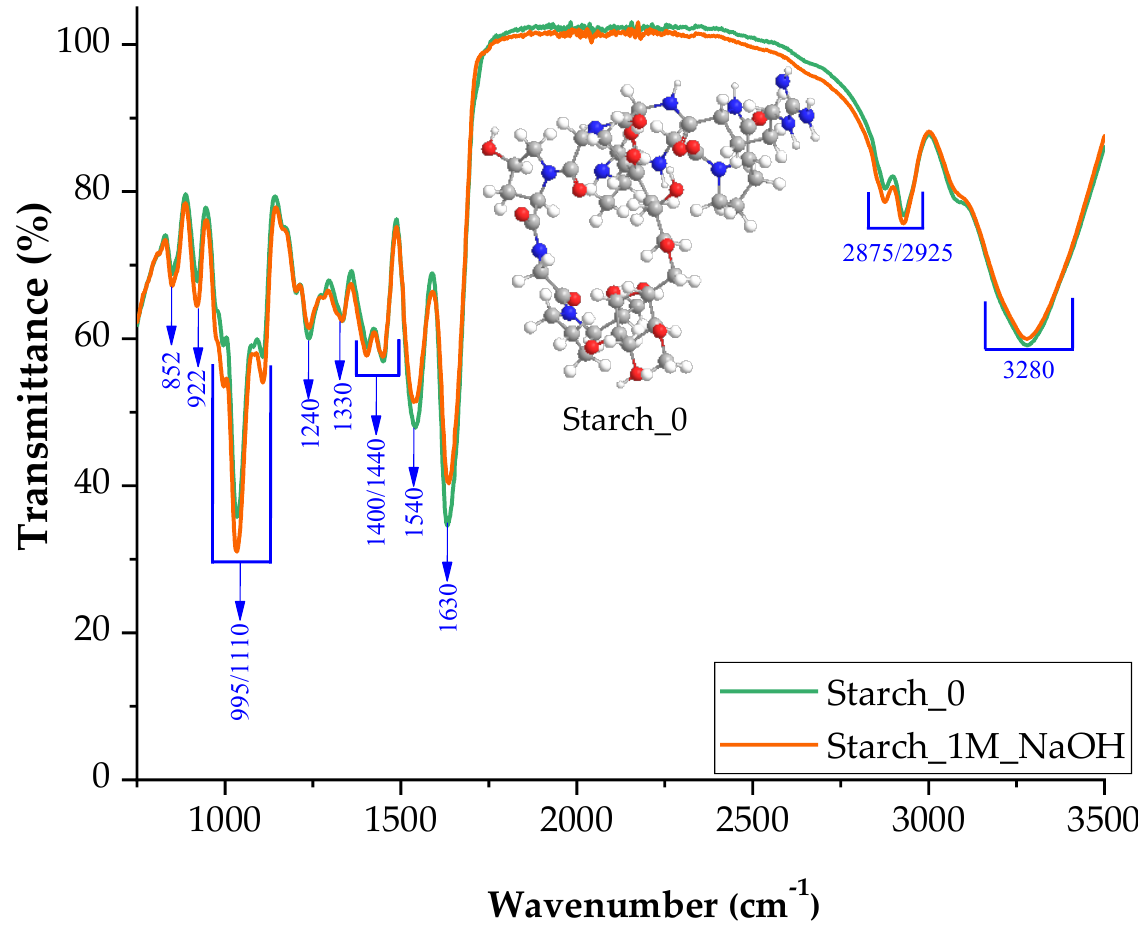
Figure 4. FTIR spectra of samples with starch additive in neutral and basic pH (1M NaOH).